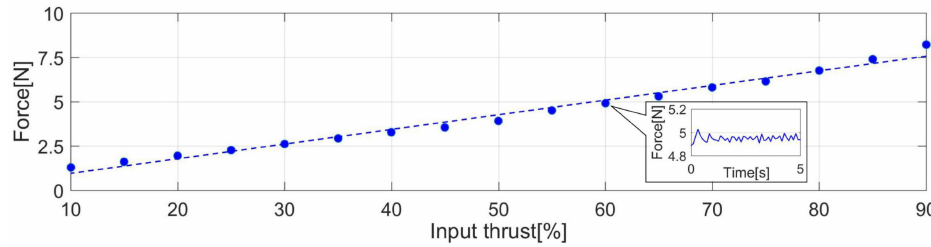
Figure 6. Experimental result on output force of the ATD for different input thrust. The linear approximation is y = 0.0826 x +